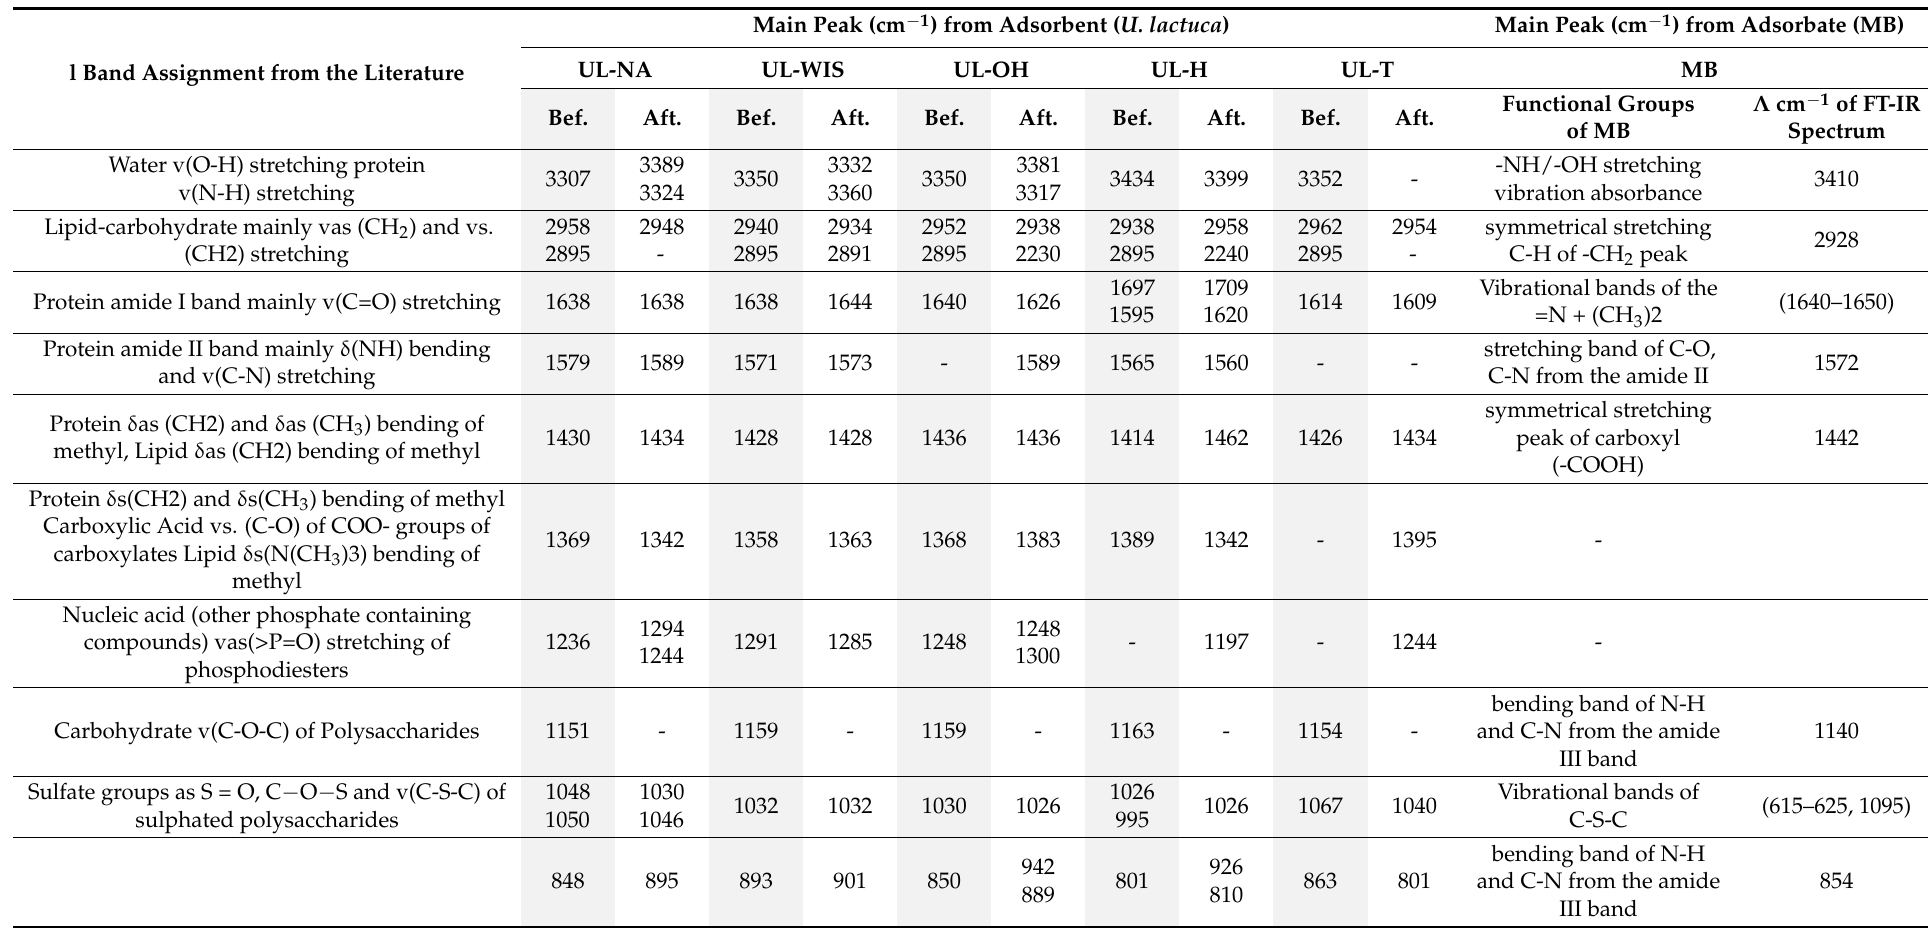
Table 2. Assignment of bands found in FTIR spectra of different adsorbent UL-NA, UL-WIS, UL-OH, UL-H, and UL-T and the MB adsorbate.